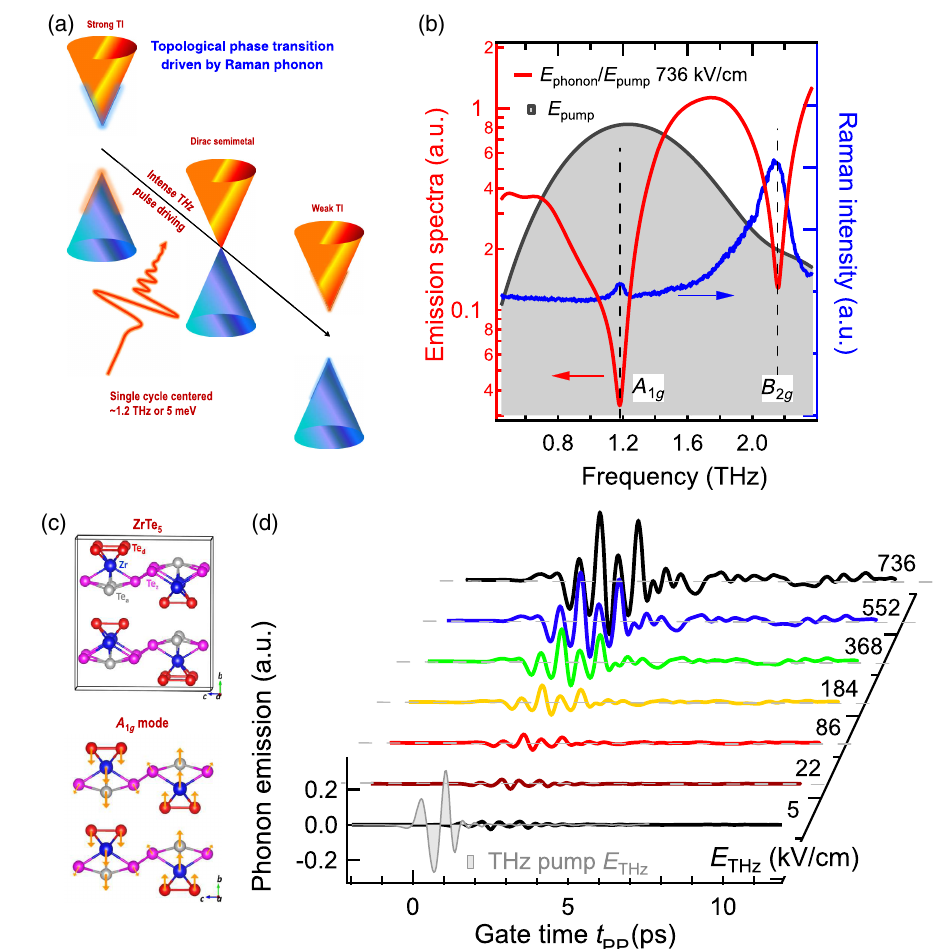
FIG. 1. Intense THz-driven Raman phonon coherence in ZrTe 5 . (a) Schematic of the topological switching driven by the THz coherent excitation in Dirac semimetals. (b) Spectrum of the coherent phonon emission (red) obtained from the time-domain traces shown for ¼ 736 kV = cm. The pump THz spectrum is shown in gray. Dashed lines indicate the identification of maximum THz-field strengths E max the excited modes in the driven states with the measured Raman spectrum (blue). (c) Crystal structure of ZrTe 5 and the relative atomic displacements of the A 1 Raman mode leading to the modulation of interlayer spacing. The arrows indicate the direction and magnitude g of the atomic displacements. (d) Time-domain traces of the measured coherent phonon emission for various THz-field strengths. The THz-driving pulse is shown in